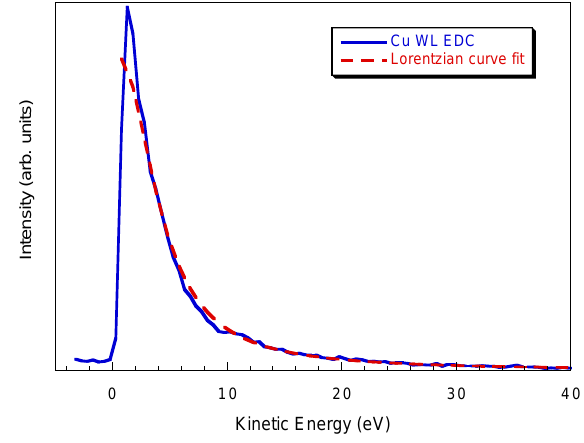
FIG. 15. (Color) The Lorentzian fit to Cu WL EDC.